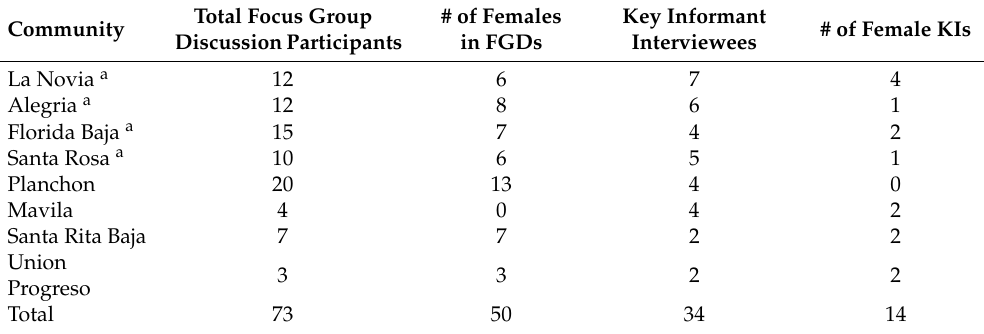
Table 1. Qualitative data collection summary.